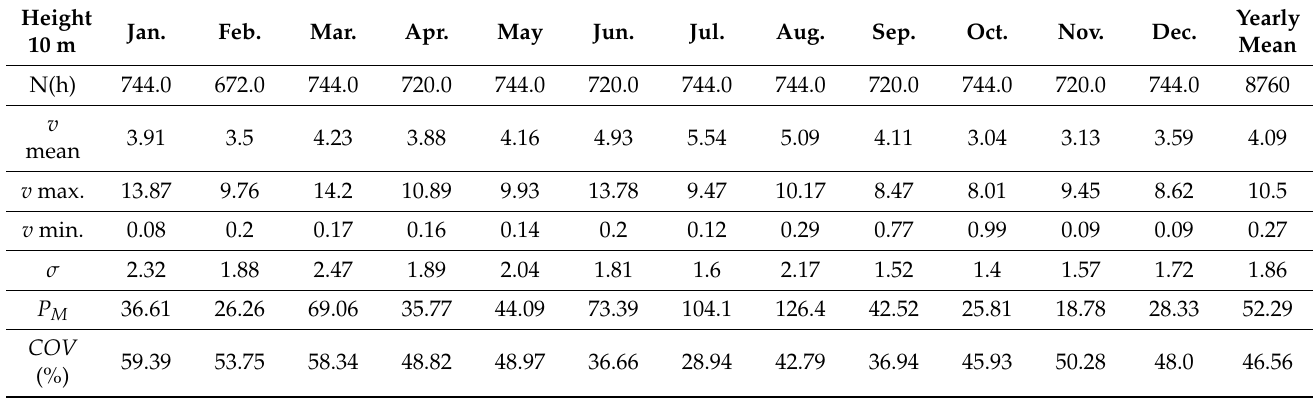
Table 7. The monthly of mean wind speed in (m/s) and ( COV ) coefficient of variation at 10 m height during the period 2019.